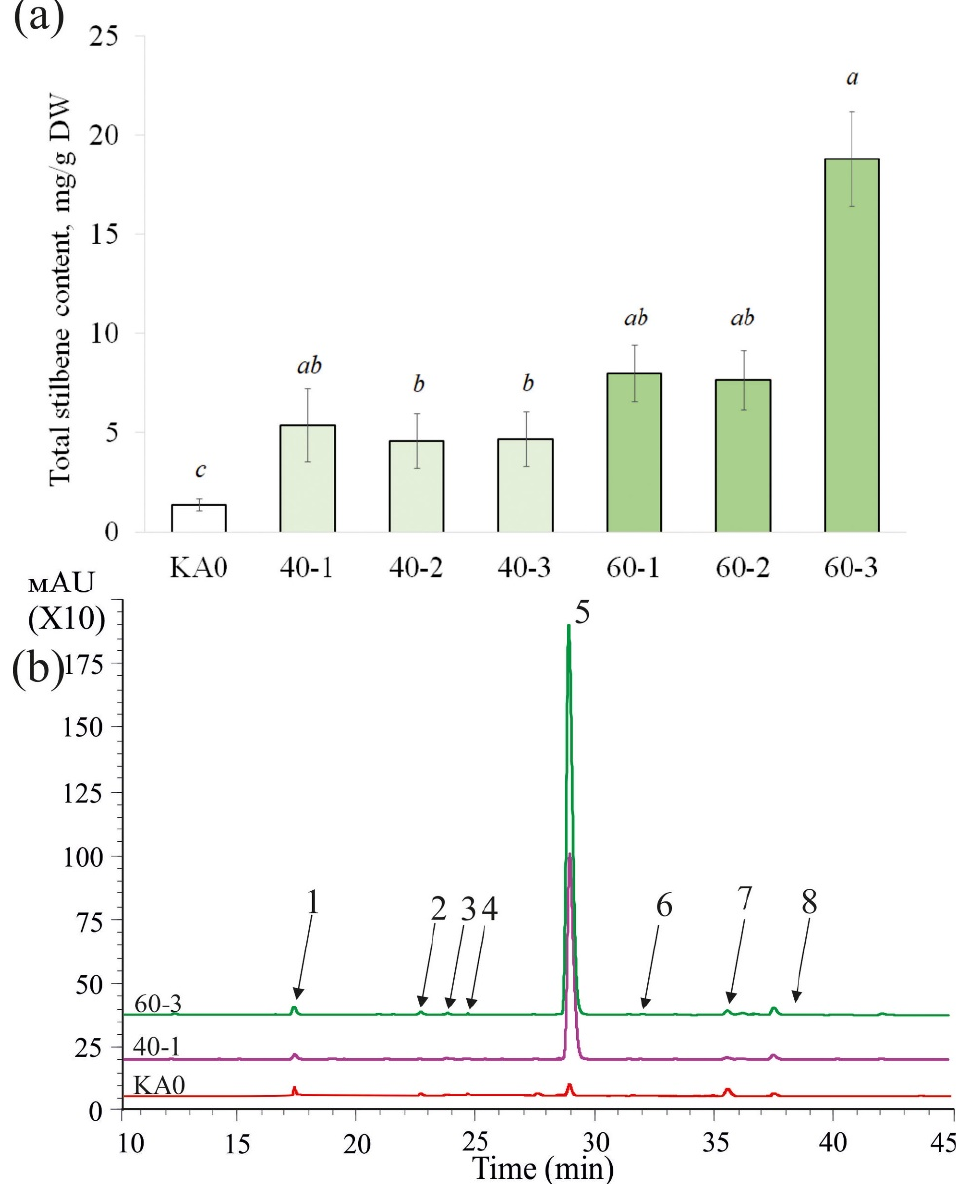
Figure 2. Total stilbene content (( a ), mg per g of the dry weight (DW)) and a representative HPLC- UV profile (( b ), 310 nm) of the callus cell lines of Vitis amurensis transformed with the VaMyb40 or VaMyb60 genes. KA0—control cell line transformed with the vector harboring only the npt II selective marker; 40-1, 40-2, 40-3—cell lines of Vitis amurensis transformed with the VaMyb40 gene; 60-1, 2, 3—cell lines of V. amurensis transformed with the VaMyb60 gene. T -resveratrol diglucoside (1), t -piceid (2), t -piceatannol (3), cis -piceid (4), t -resveratrol (5), cis -resveratrol (6), t - ε -viniferin (7), t -delta-viniferin (8). Means followed by the same letter were not different using one-way analysis of variance (ANOVA), followed by the Tukey HSD multiple comparison test (three independent experiments with four technical replicates). p < 0.05 was considered statistically significant.